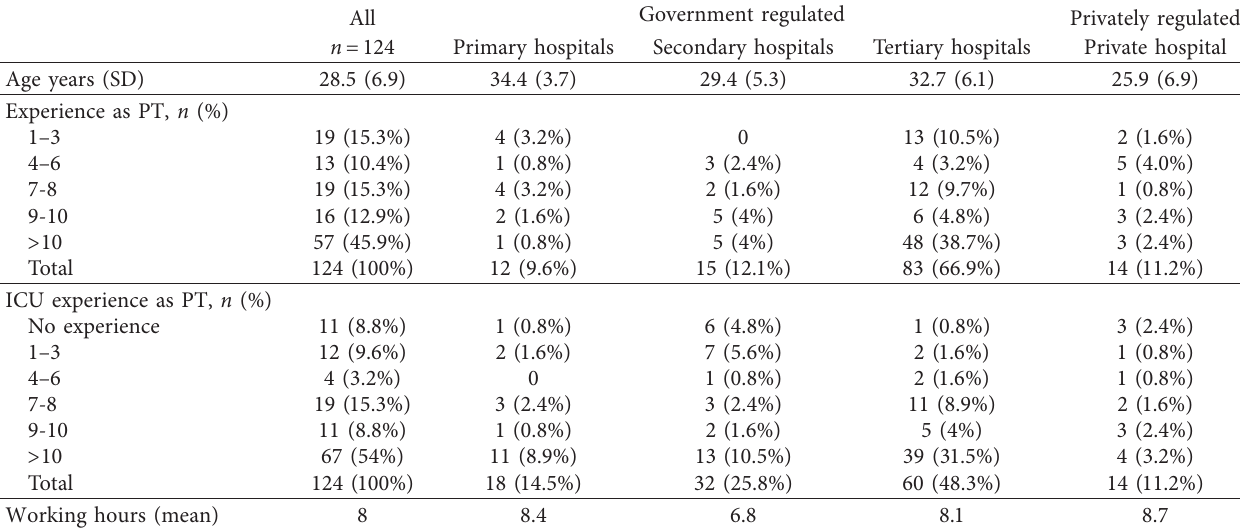
Table 1: Demographic data of the participants.